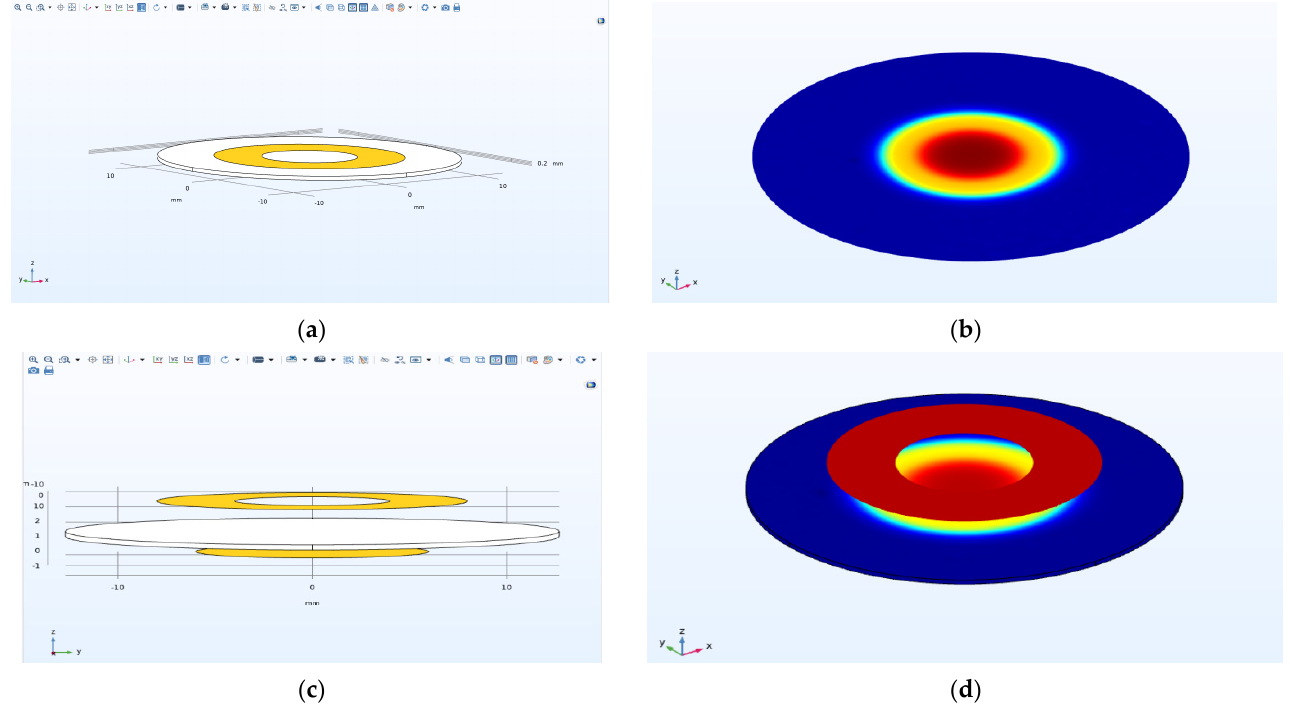
Figure 6. ( a ) Software modeling model of the polar biosensor chip; ( b ) surface potential distribution of the polar biosensing chip; ( c ) software modeling model of the electrodeless biosensing chip; ( d ) surface potential distribution of the electrodeless biosensing chip.